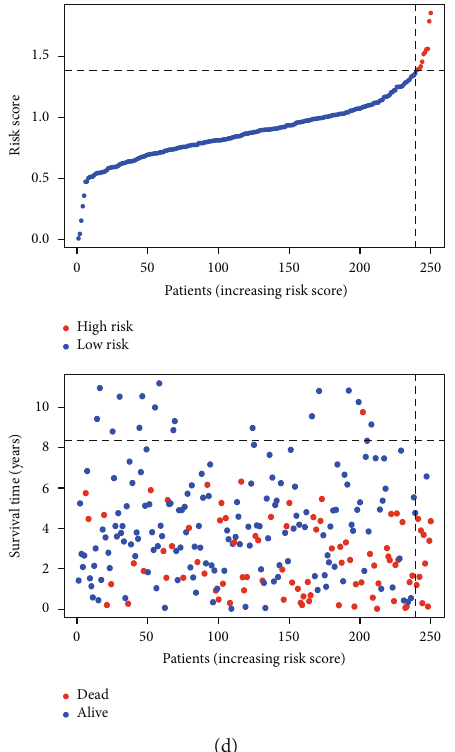
Figure 7: Validation of the prognostic risk signature in the testing cohort. (a) Kaplan-Meier curve analysis shows the OS of high-risk ( n = 10 ) and low-risk ( n = 236 ) ccRCC patients in the testing cohort. (b) ROC curve analysis in the testing cohort shows the false positive rate vs. true positive rate plots based on the prognostic risk signature. The AUC values for 1-year (green), 2-year (blue), and 3-year (red) survival rates are also shown. (c) The expression heatmap of the seven prognostic-risk related m 5 C RNA methylation regulators in the high-risk (blue) and low-risk (pink) ccRCC patients of the testing cohort. ∗∗ p < 0 : 01 ; ∗∗∗ p < 0 : 001 . (d) The distributions of risk scores of the high- risk (red) and low-risk (blue) ccRCC patients and corresponding survival time (the red dots represent the dead patients and the blue dots represent the alive patients) in the testing